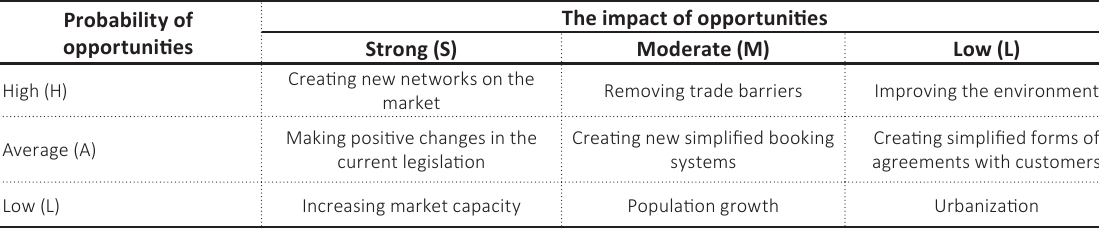
Table 8. Opportunities for tourism infrastructure companies